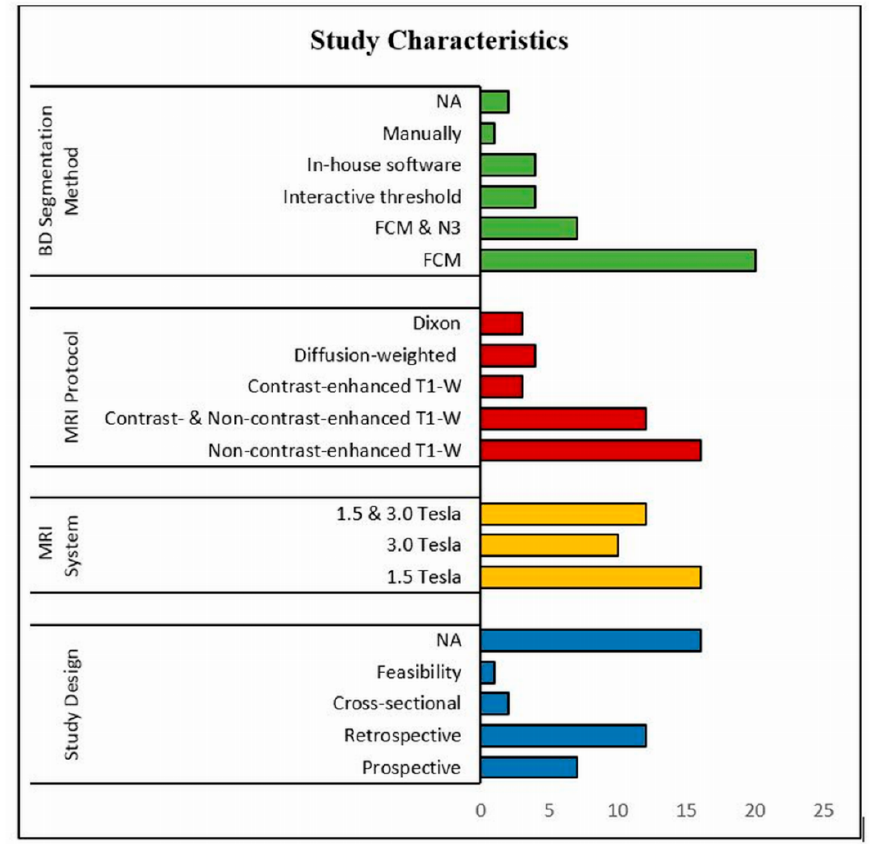
Figure2. Flowchartofthestudycharacteristics(studydesign, MRIsystem, MRIsequence, BreastDensity Figure 2. Flowchart of the study characteristics (study design, MRI system, MRI sequence, Breast (BD) segmentation method) of 38 Density (BD) segmentation method) of 38 studies.